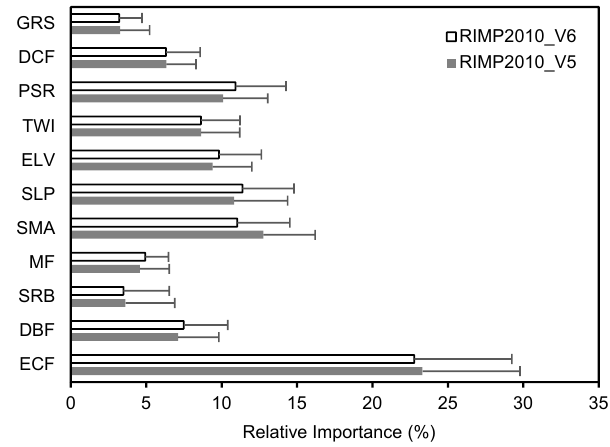
Figure A4. The relative importance (RIMP) of variables generated by 50 boosting regression tree (BRT) models using two different versions (V5 and V6) of surface moisture availability (SMA) derived from MODIS ET products. Variable abbreviations were described in Table 2.